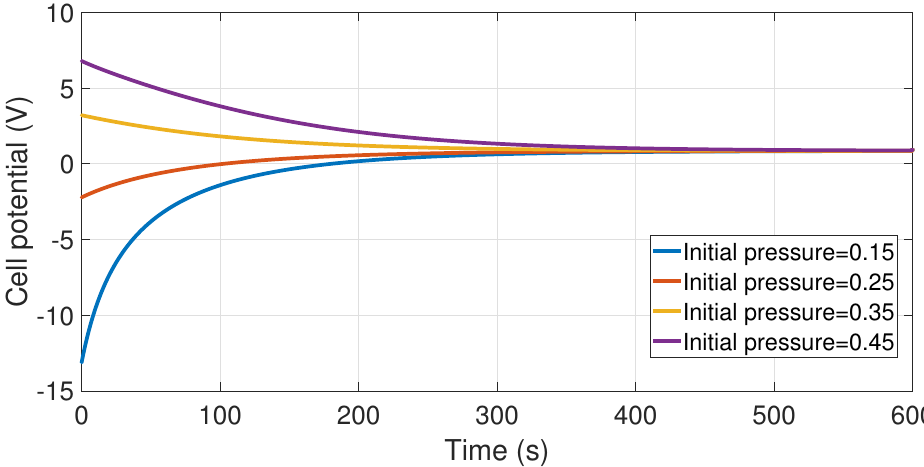
Figure 7. Simulation of potential stability with different values θ 0